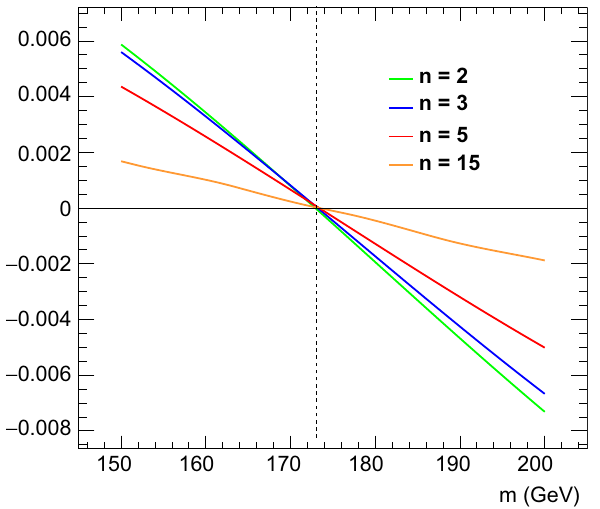
Fig. 4 Weighted sums I ( m ) over the unfolded lepton energy distri- bution with the weight functions corresponding to n = 2, 3, 5, 15. The input value of the top-quark mass is 173 GeV, as its position is indicated by a dashed line. The horizontal axis is the mass parameter m used in the calculation of W ( E (cid:2) , m ) . The top-quark mass is reconstructed from I ( m = m rec t ) = 0